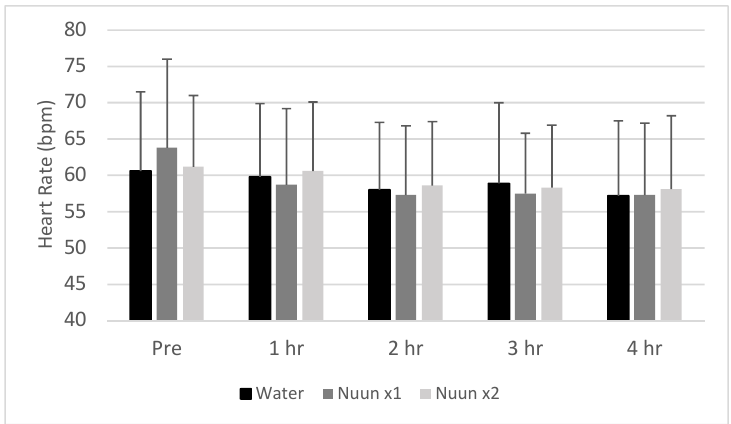
Figure 1. Heart rate response of 18 men and women to water only and Nuun + water; Values are mean ± standard deviation; bpm is beats per min, hr is hour(s) after condition ingestion, Nuun x1 is Nuun beverage at normal concentration, Nuun x2 is Nuun beverage at double concentration; No differences of statistical significance were noted ( p > 0.05).